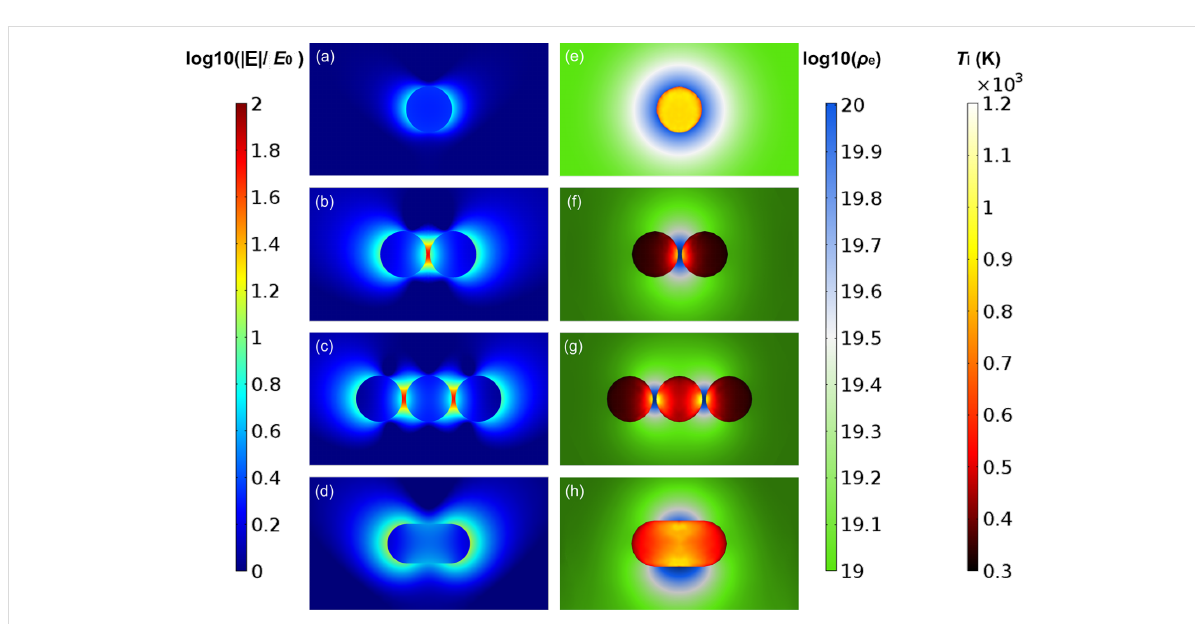
Figure 4: (a–d) Plots of the relative electric field enhancement, log 10 (| E |/ E 0 ), of 25 nm nanospheres and nanorods, where | E | is the amplitude of the calculated electric field and E 0 is the amplitude of the incident electric field, polarized along the long axis of the nanostructure with propagation from the bottom of the page towards the top. (e–h) the log-scale of free-electron density plasma, log 10 ( ρ e ) (cm − 3 ), 4 ps delayed after the temporal peak of the incident laser pulse intensity and the lattice temperature, T l (K), of the nanoparticle sampled at the end of the pulse duration. All plots are pro- duced for nanoparticles irradiated at the resonance wavelength (see Figure